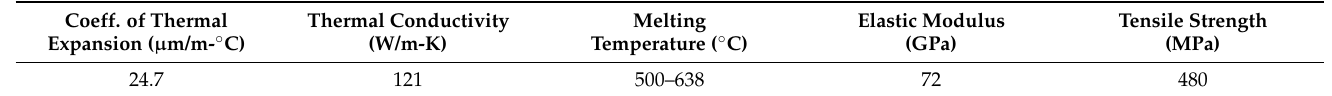
Table 1. Primary physical and mechanical properties of aluminum 2024-T3 at room temperature